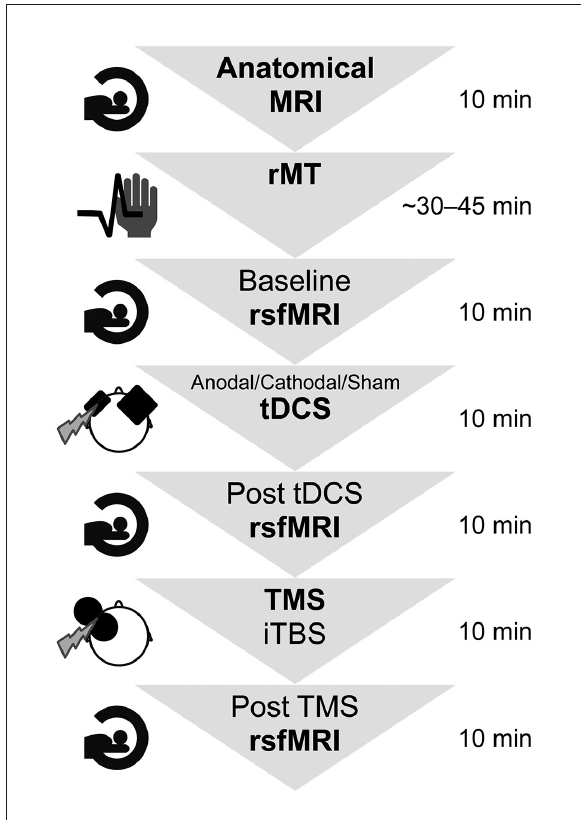
FIGURE1 Summary of the experimental design and durations. First, the participants entered the MRI scanner for 10 min to create anatomical images. Afterwards, their individual resting motor threshold was determined, which took approximately 45 min. The experiment comprised two brain stimulation sessions as well as three functional resting state functional MRI scans lasting approximately 10 min each. The whole experimental procedure took in total approximately 2 h per participant. rsfMRI, resting state functional magnetic resonance imaging; rMT, resting motor threshold; tDCS, transcranial direct current stimulation;